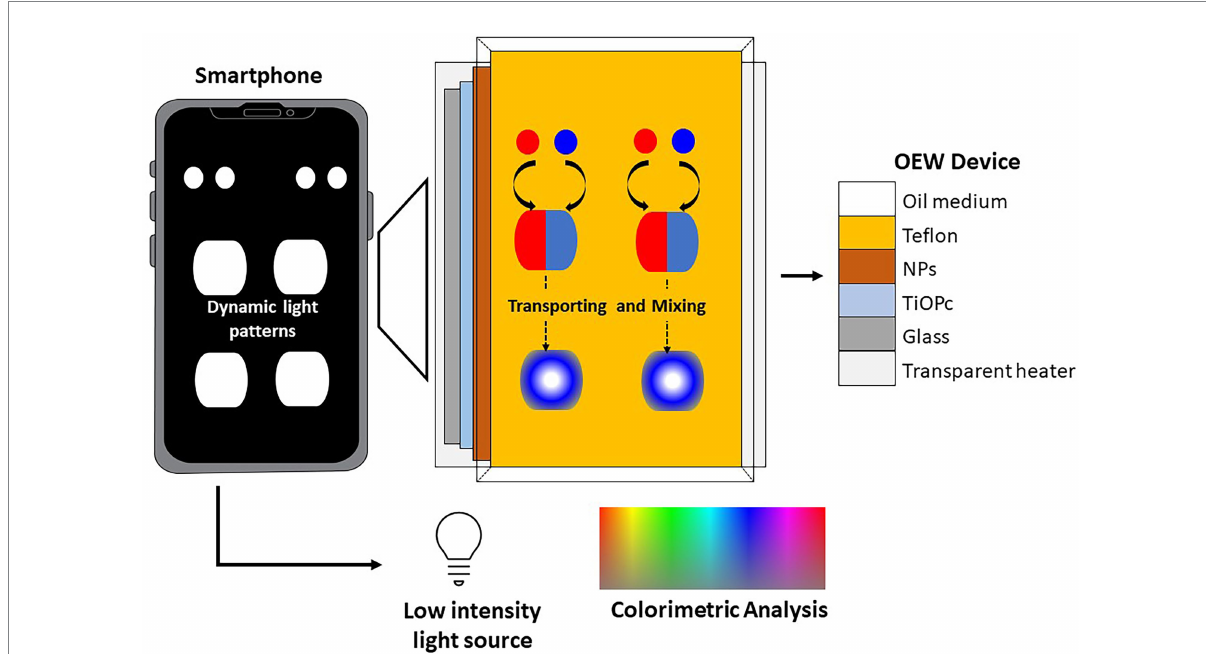
FIGURE 6 A low-cost lab-on-a-smartphone (LOS) for on-site monitoring of E. coli in environmental water, which was comprised of plasmonic-enhanced optoelectrowetting (OEW) device (Thio et al.,